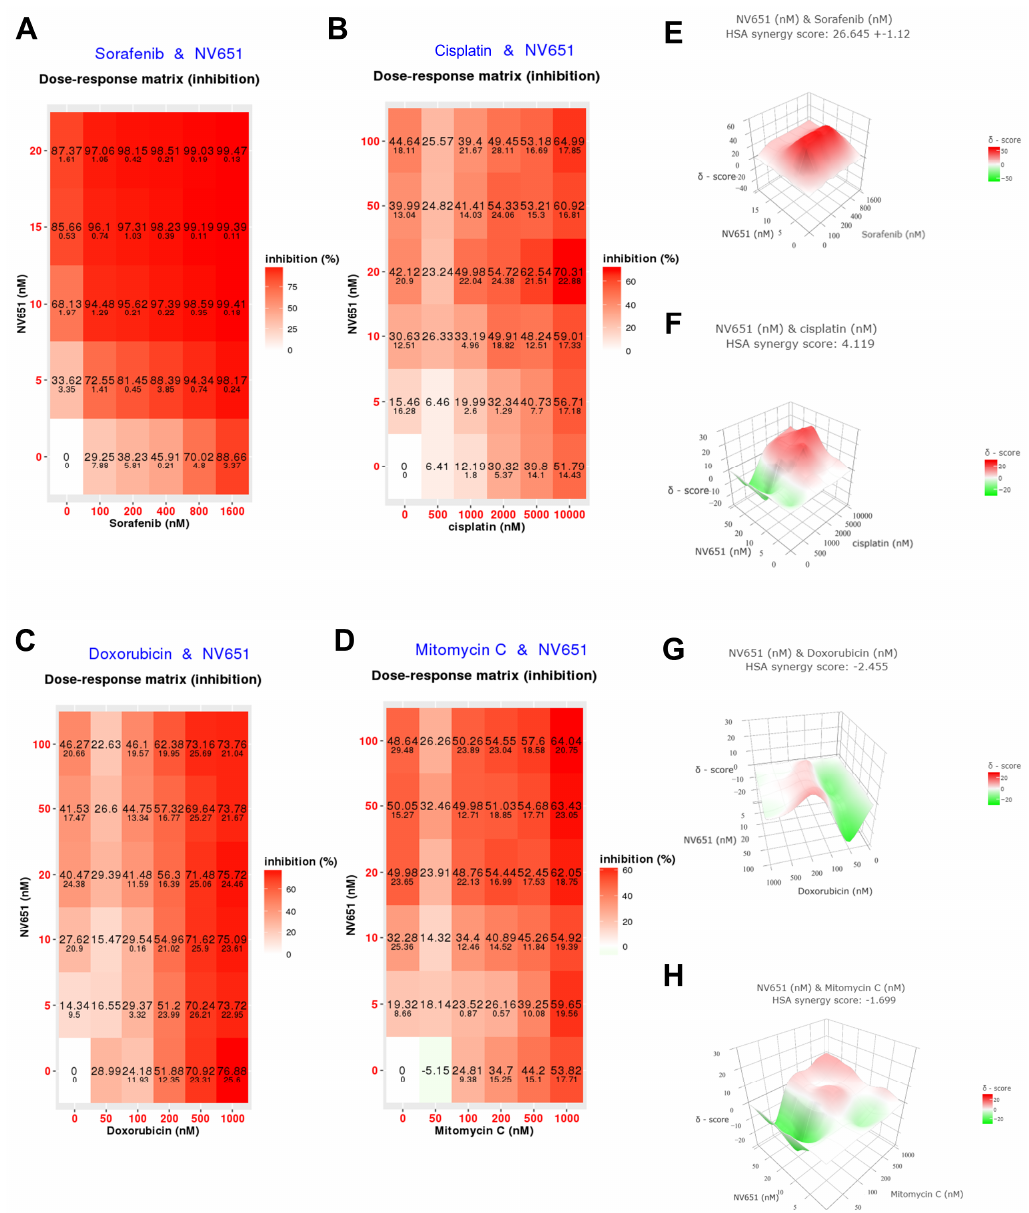
Figure 3. Synergistic effect of NV651 and HCC treatments in HEPG2 cells. ( A – D ) Effect on cell proliferation in HEPG2 cells. ( A ) HEPG2 cells were treated with NV651 in combination with sorafenib for 168 h and cell proliferation was analysed with Acumen n = 2 biological replicates. ( B – D ) Percent inhibition of NV651 in combination with Cisplatin, Doxorubicin or Mitomycin after 72 h of treat- ment, analysed with resazurin. N = 1–3 biological replicates. ( E – H ) Synergy score calculated with the highest single agent (HSA) from each data presented in ( A – D ).